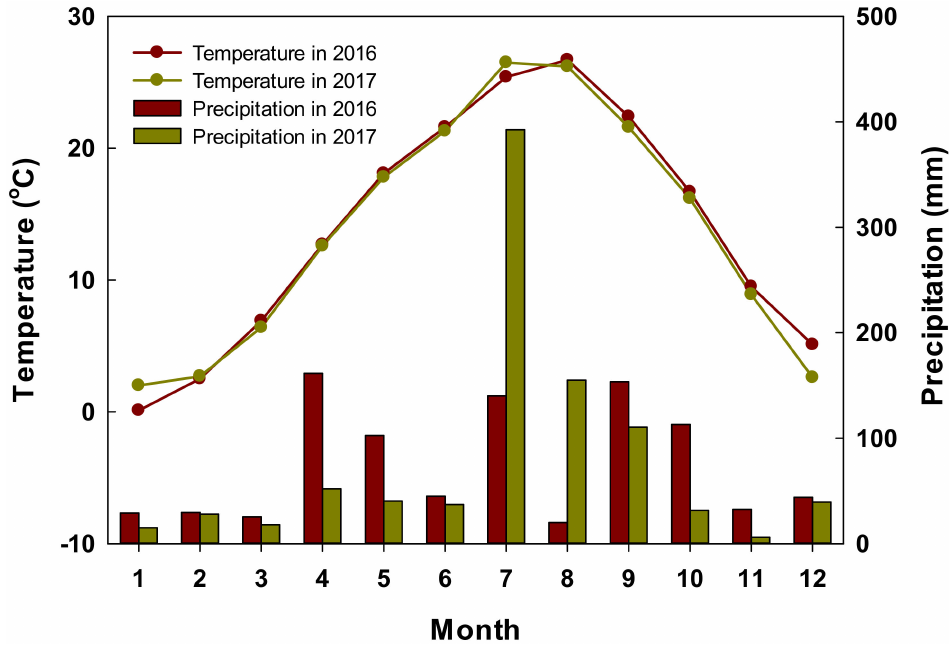
Figure 1. Mean monthly temperature and precipitation during the study period in the experimental